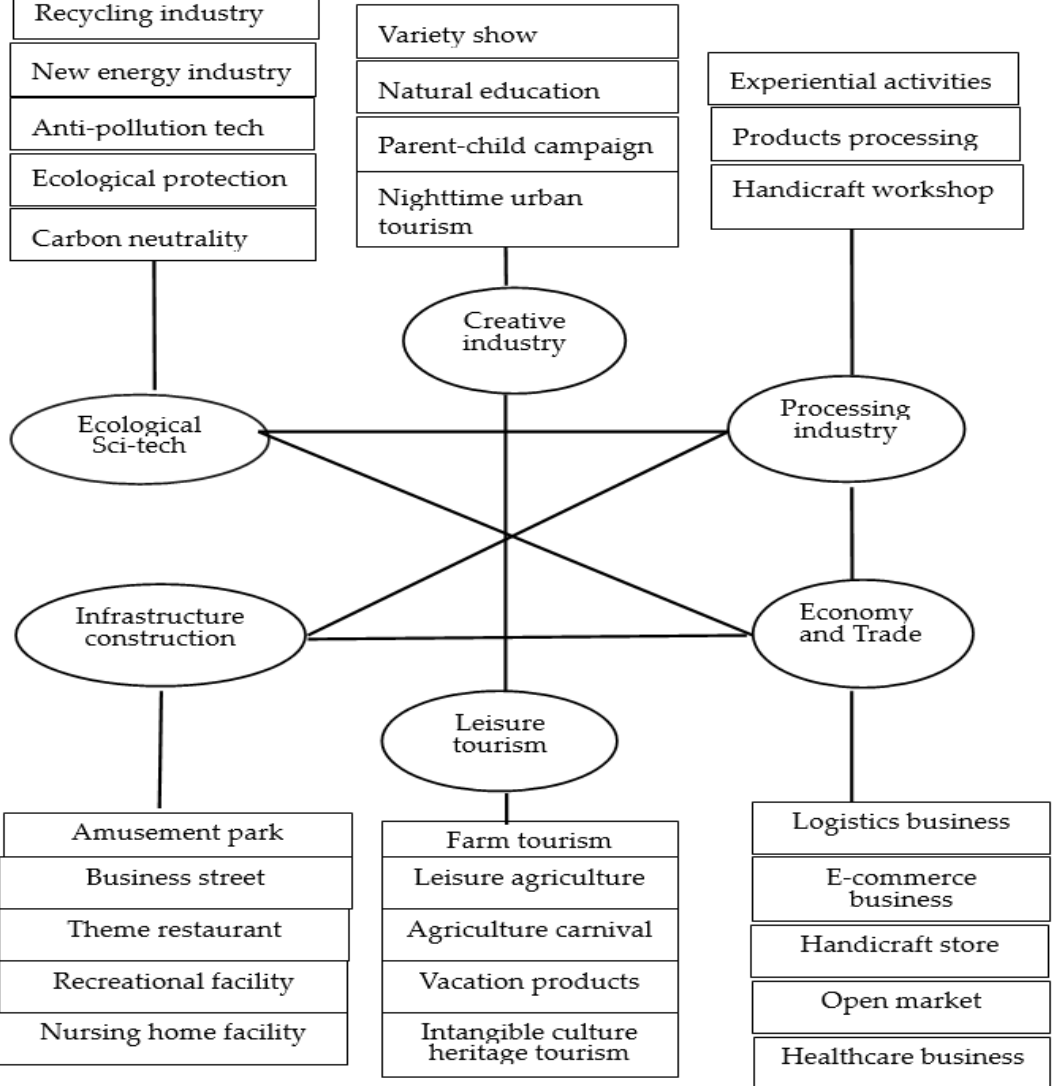
Figure 6. Industrial cluster framework of the rural complex. (Source: Drawn by the Authors).